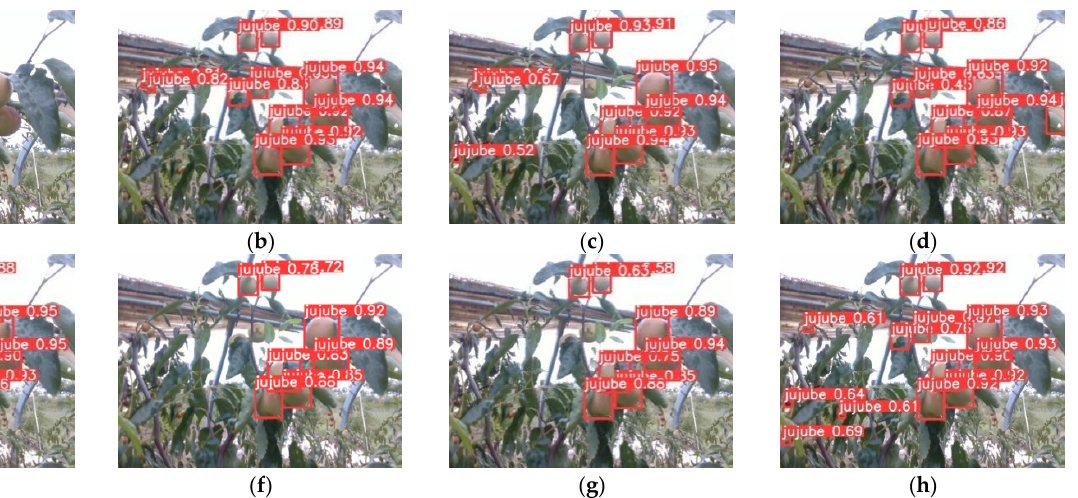
Figure 11. Original image and test results of different algorithms. ( a ) Original image; ( b ) Yolov5s; ( c ) Yolov3-tiny; ( d ) Yolov4-tiny; ( e ) Yolov7-tiny; ( f ) SSD; ( g ) Faster RCNN; ( h ) Optimized Yolov5s model. The P–R curve is a curve with Recall as the horizontal coordinate and Precision as the vertical coordinate, and its area can be expressed as the comprehensive performance of the winter jujube target detection model. As can be seen from Figure 12, the curve area of the Yolo series is significantly larger than that of the SSD and Faster RCNN, which indicates that the Yolo series models have a fine detection effect for winter jujube target detection.